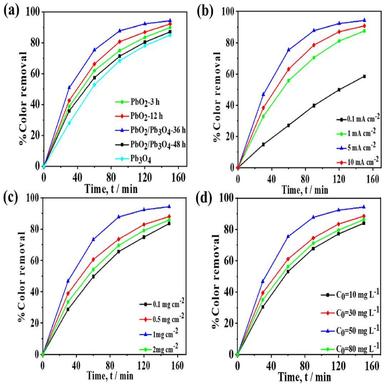
MO color removal efficiency affected by (a) anode material; (b) catalyst loading amount; (c) current density; (d) initial MO concentration. (For interpretation of the references to color in this figure legend, the reader is referred to the Web version of this article.)